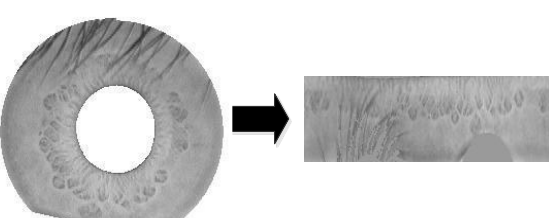
Figure 10. Transforming iris area into normalized rectangular